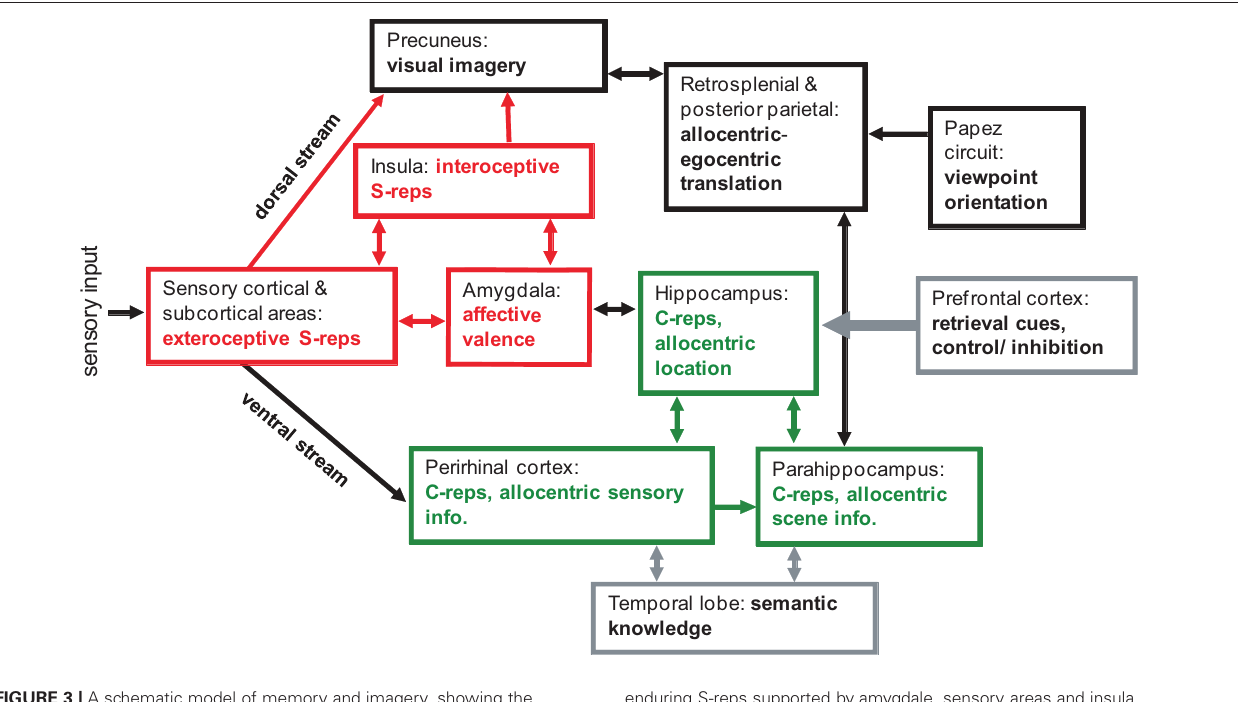
FIGURE 3 | A schematic model of memory and imagery, showing the approximate regions and pathways involved in, and supporting, abstracted contextual representations (C-reps, in green) and sensory bound representations (S-reps, in red). Scenes with strong affective content create